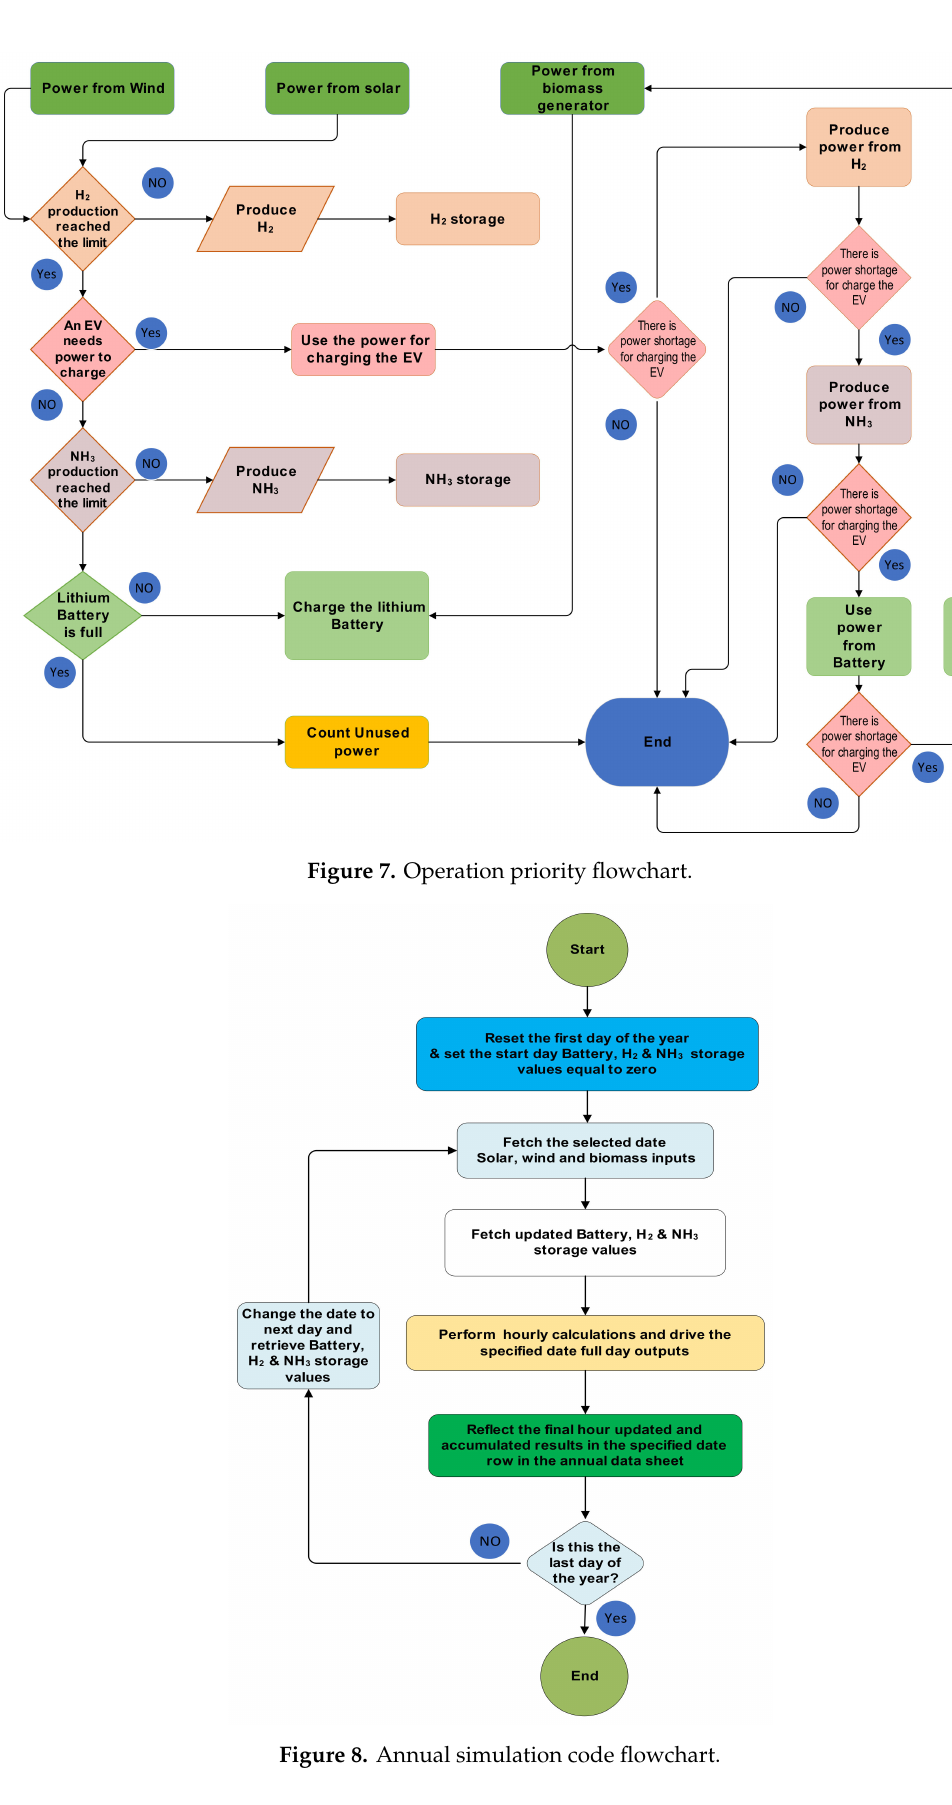
Figure 8. Annual simulation code